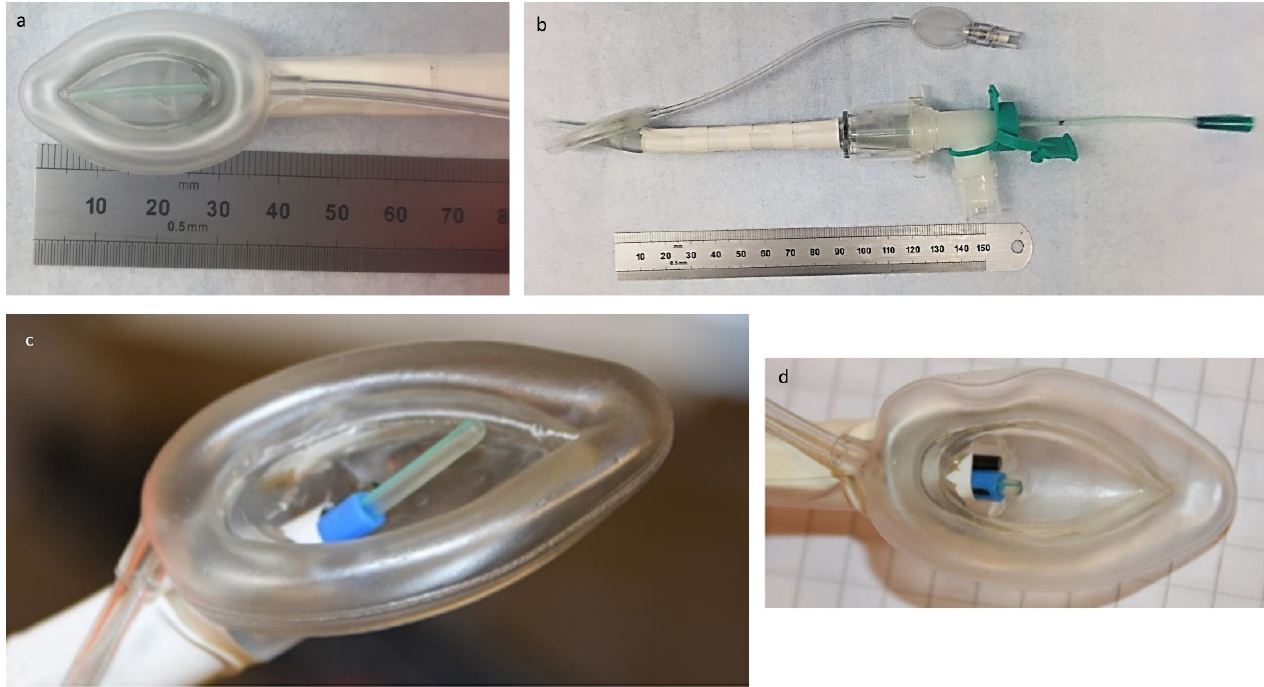
Figure 1. Laryngeal mask prototypes used in the study. ( a , b ) Panels: modified laryngeal mask airway of type Unique, size 1, with swivel and catheter; ( c , d ) panels, modified laryngeal mask of type Unique, size 1, with integrated catheter channel (blue) and camera (black).